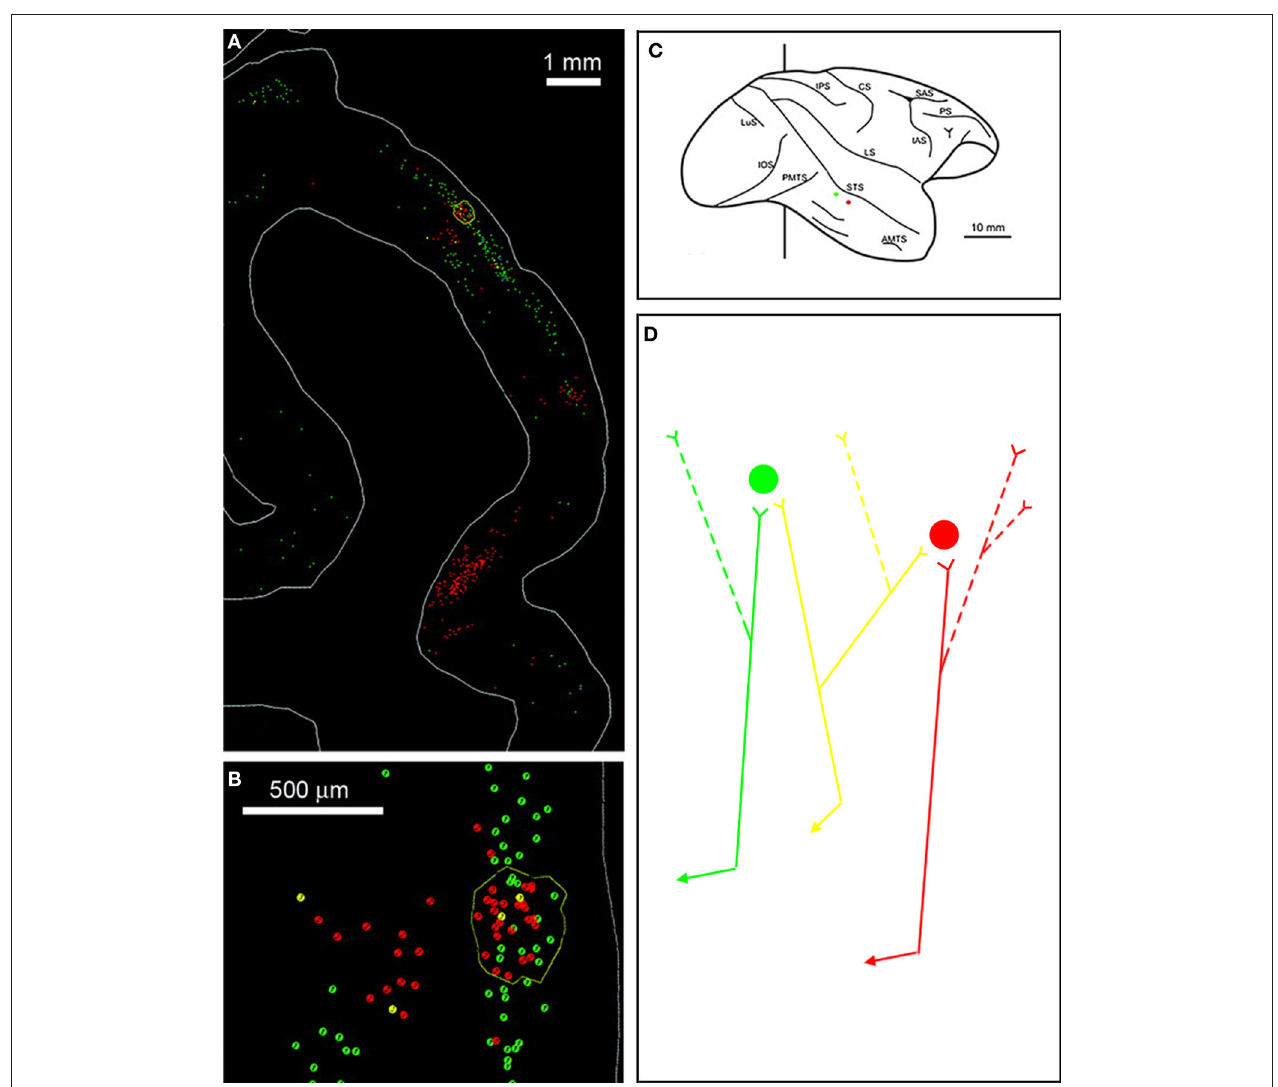
neurons are intermixed and where there are also double-labeled neurons. (D) The interpretation, consistent with analysis of anterogradely labeled single axons, is that neurons have branched arbors. Three neurons are represented schematically by colored triangles, and their branched axons by corresponding colored lines. Only some of the arbors (solid lines) will be labeled by a given injection, while others will fall outside the injected area (dashed lines). Modified from Figure 5, Borra et al.